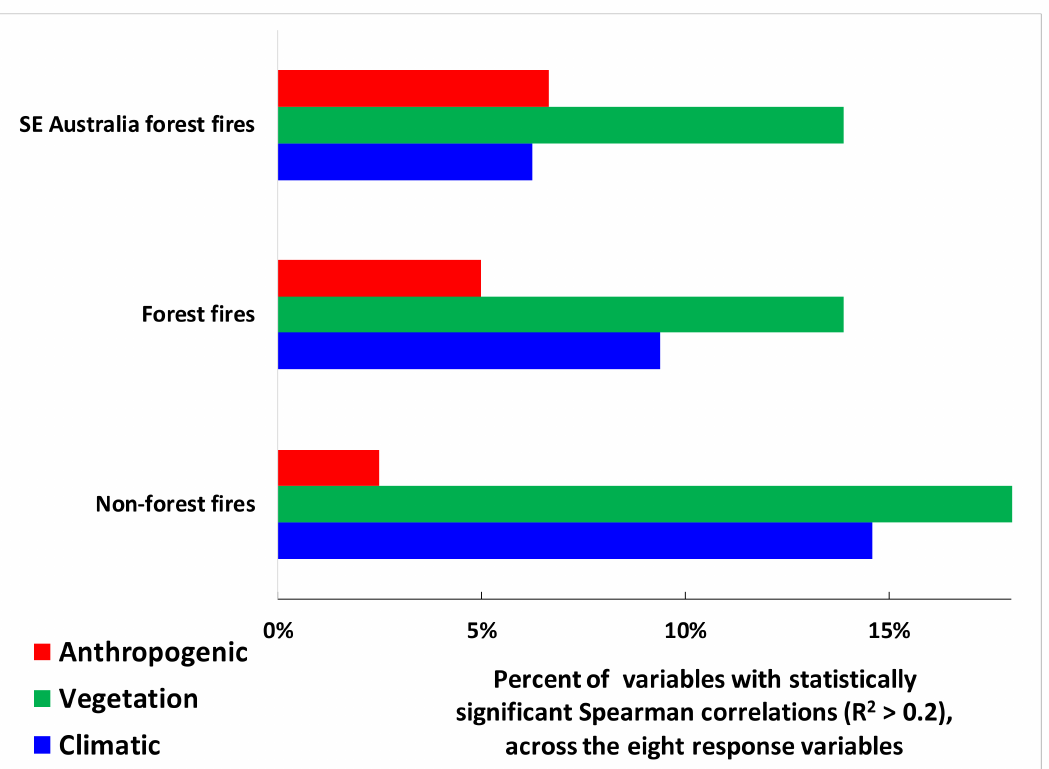
Figure 9. The percentage of explanatory variables (classified into anthropogenic, vegetation or climatic variables) with statistically significant Spearman correlation coefficients (R 2 > 0.2) across the eight response variables for Black Summer non-forest fires ( n = 186), Black Summer forest fires ( n = 205) and Black Summer forest fires in SE Australia ( n =